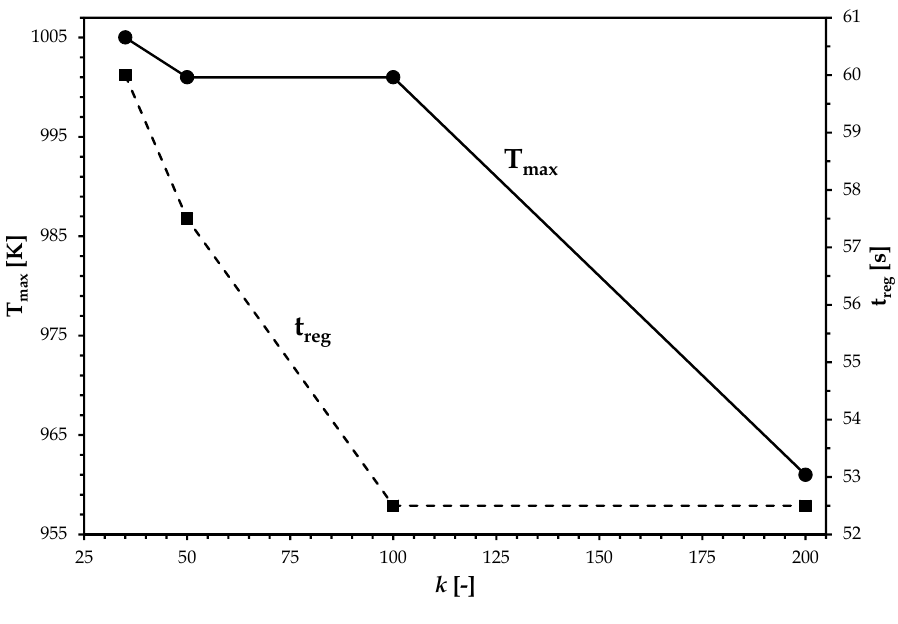
Figure 14. T max and t reg at T in = T in_optimal versus k .